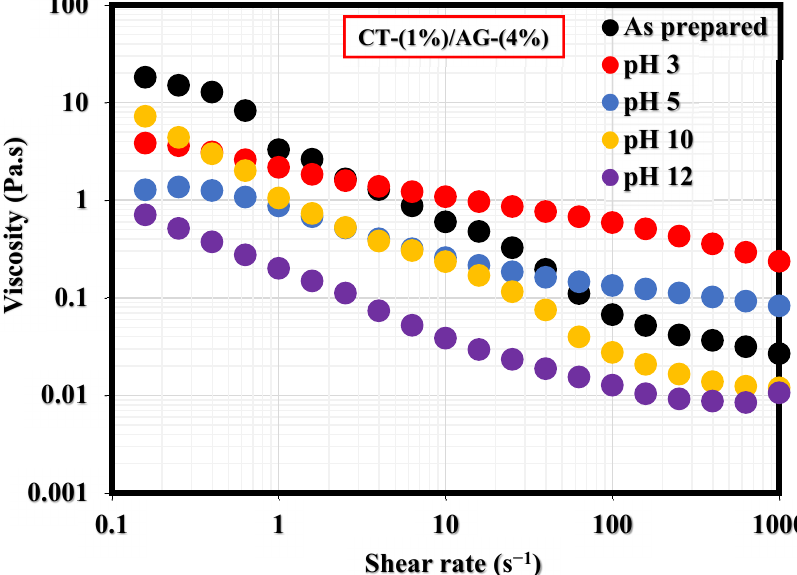
Figure 8. Viscosity behavior of 1%-CT/4%-AG emulsion under different pH levels.